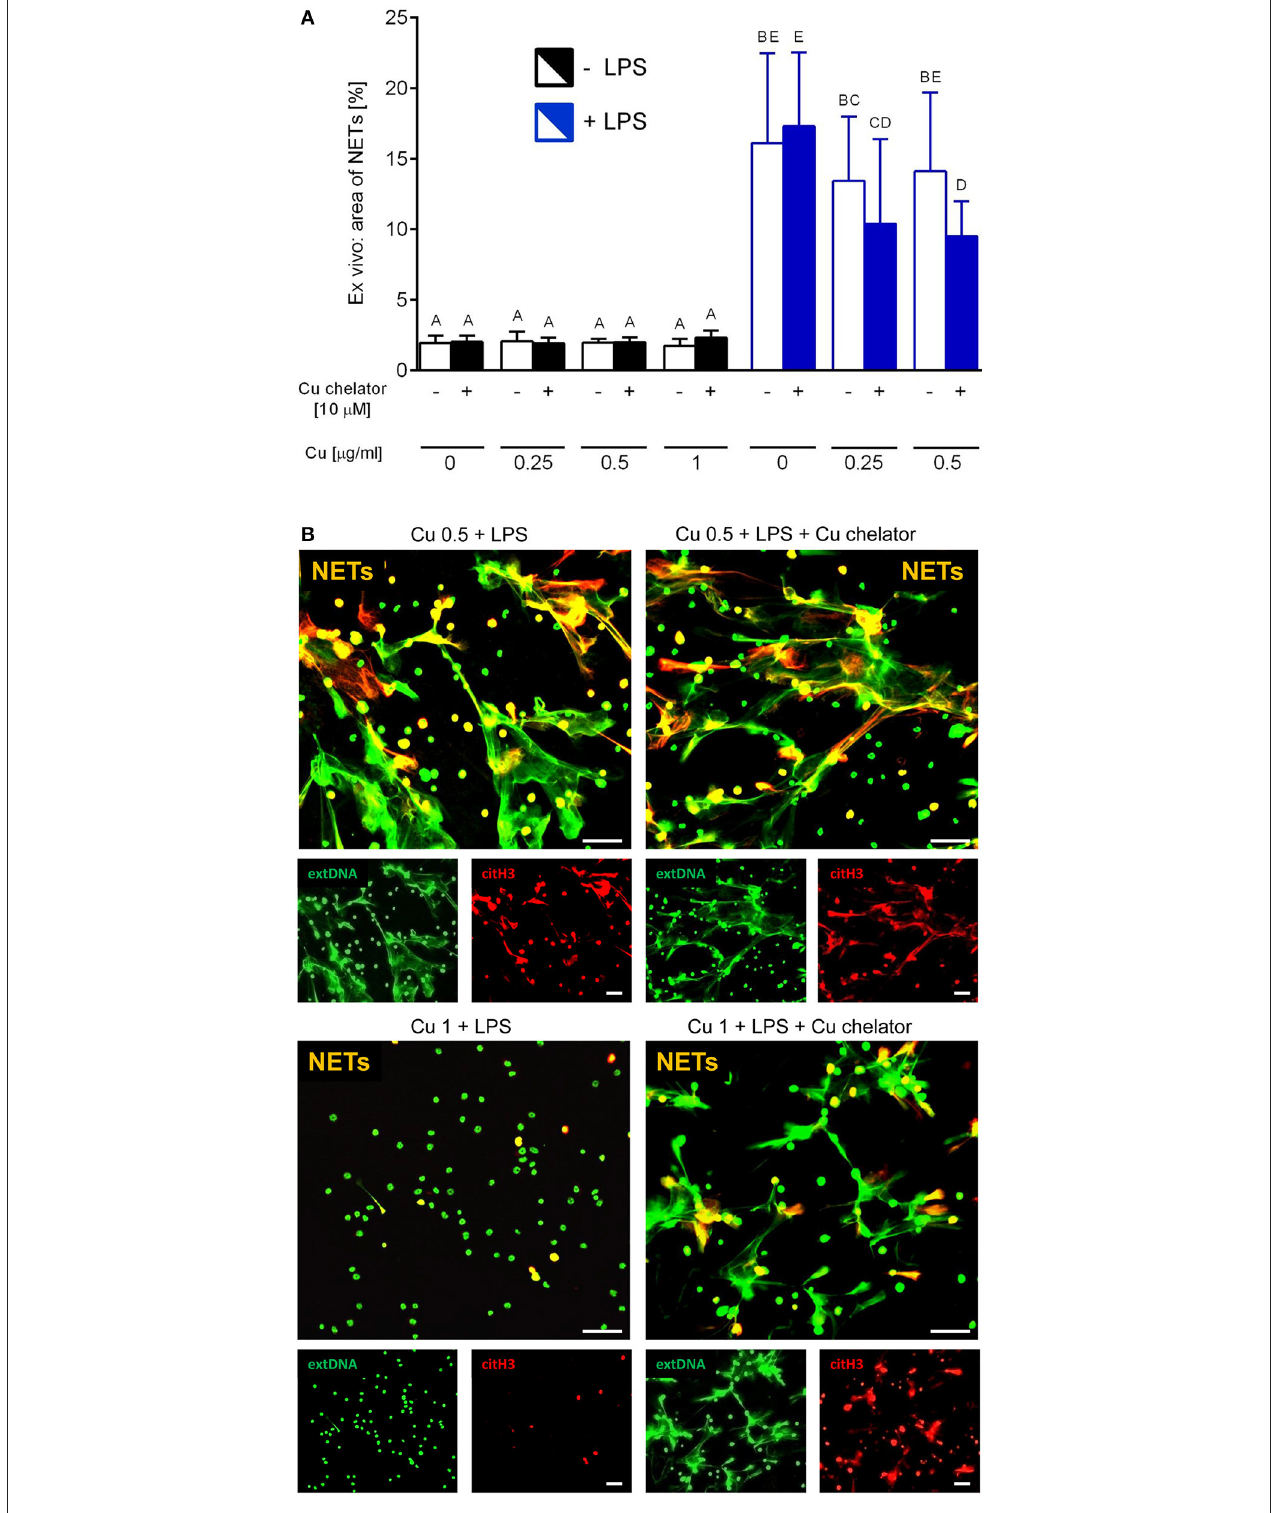
FIGURE 9 | Neutrophil extracellular trap (NET) formation in the presence of exogenous copper. Neutrophils were either incubated with LPS ( + LPS), various concentrations of copper (Cu), or left alone. Additionally, some cells were stimulated with LPS and/or copper chelator when co-cultured with the varying